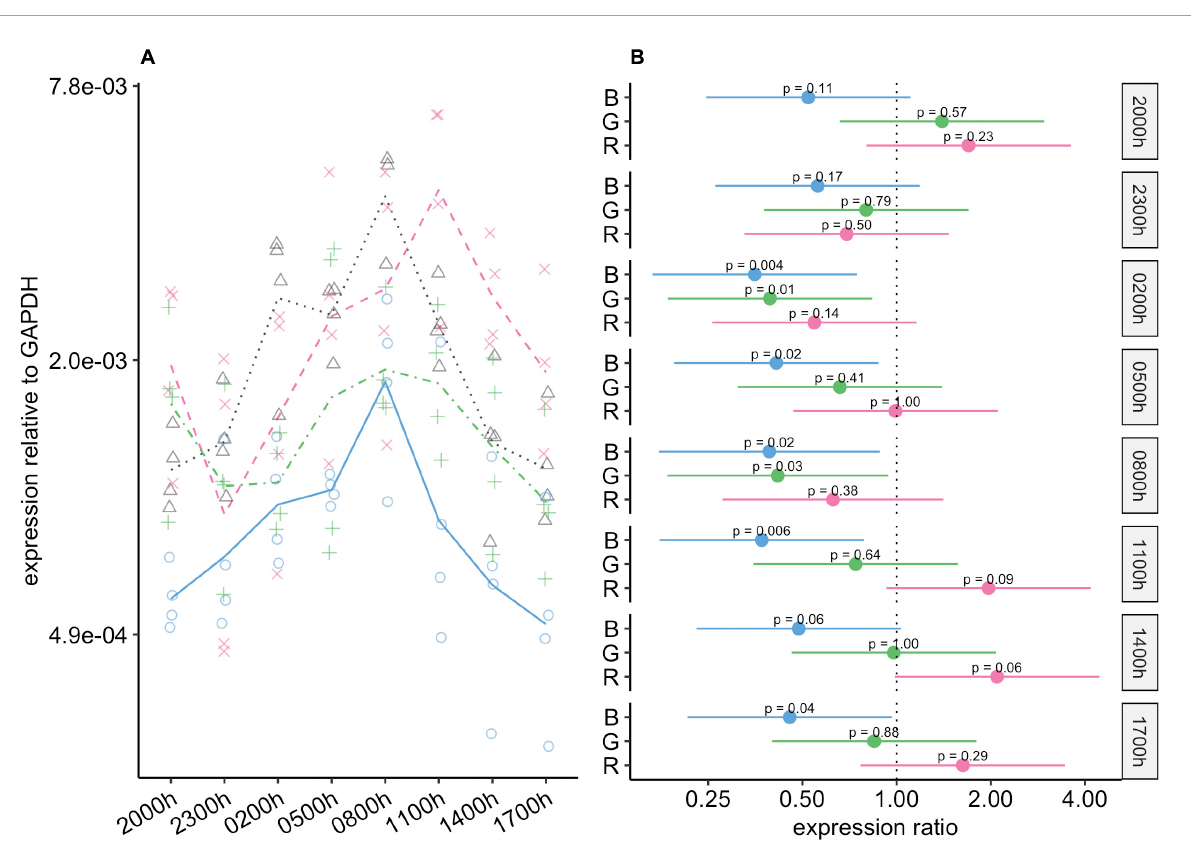
FIGURE5 Effect of monochromatic light exposure on Opn4 mRNA expression in the retinas of Wistar rats. Experimental details were the same as in Figure 1 . P -values and 95% confidence intervals were calculated with Dunnett’s test. Note that logarithmic scales are used. (A) Points show gene expression levels in individual rats; lines connect mean values in each group. To facilitate viewing by color-blind readers, different points and line types were used: control group, dotted line ( •• ) and triangles; red-light group, dashed line (– –) and x-marks; green-light group, dot-dash line ( • –) and crosses; blue-light group, solid line and circles. (B) Points show differences between group means; error bars show the 95% confidence interval for each difference. Abbreviations indicate which group is being compared to the control group: B, blue-light group; G, green-light group; R, red-light